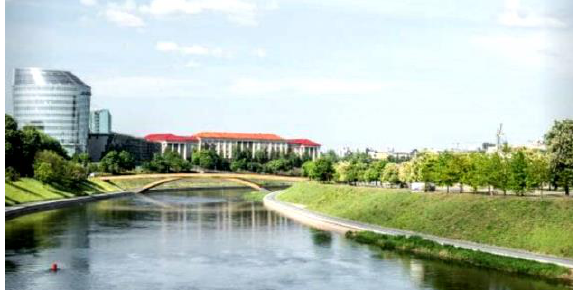
Figure 1. New infastructure project in Vilnius